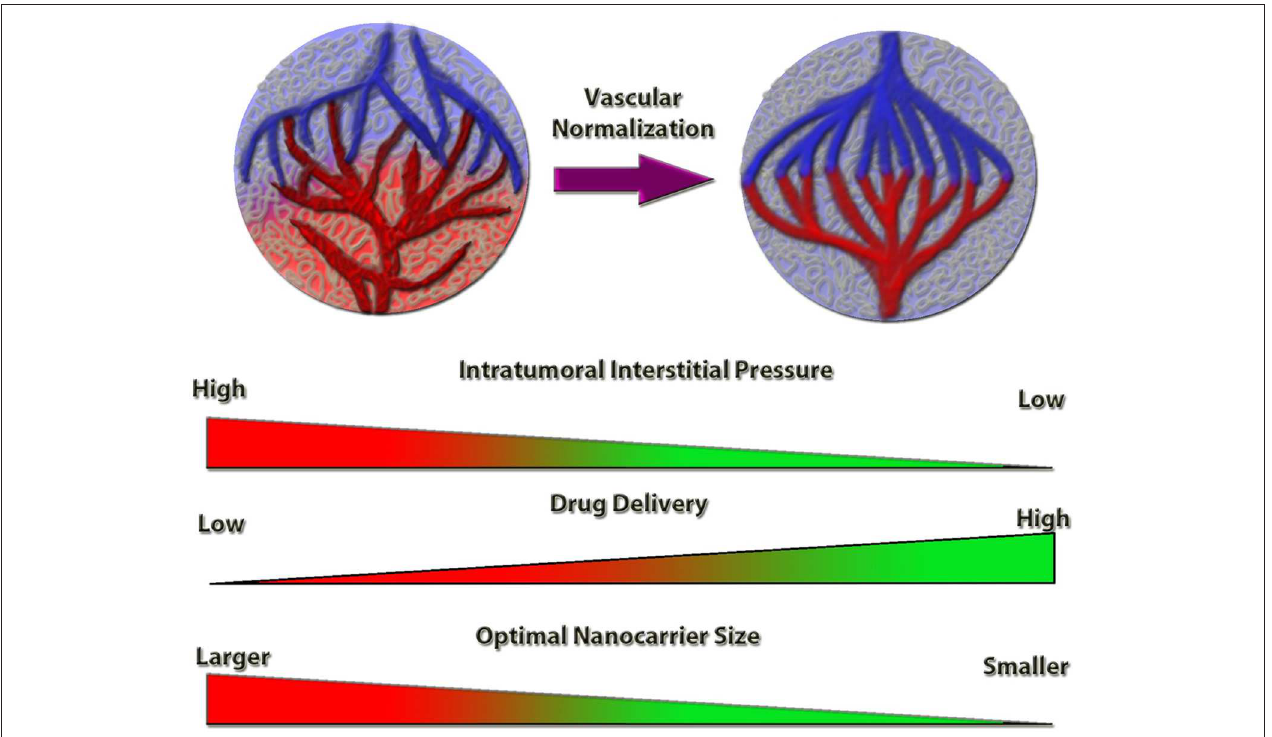
FIGURE 1 | Schematic representation of the tumor vessel normalization’s impact on intratumoral interstitial pressure and drug delivery efficiency. Normalized tumor vessels decrease tumor hypoxia and intratumoral interstitial pressure, which increases the anti-cancer drug delivery efficiency. Nanocarrier size is a limiting factor for optimal targeting and delivery, the efficiency of which is inversely proportional to the nanocarrier size, under vessel normalization